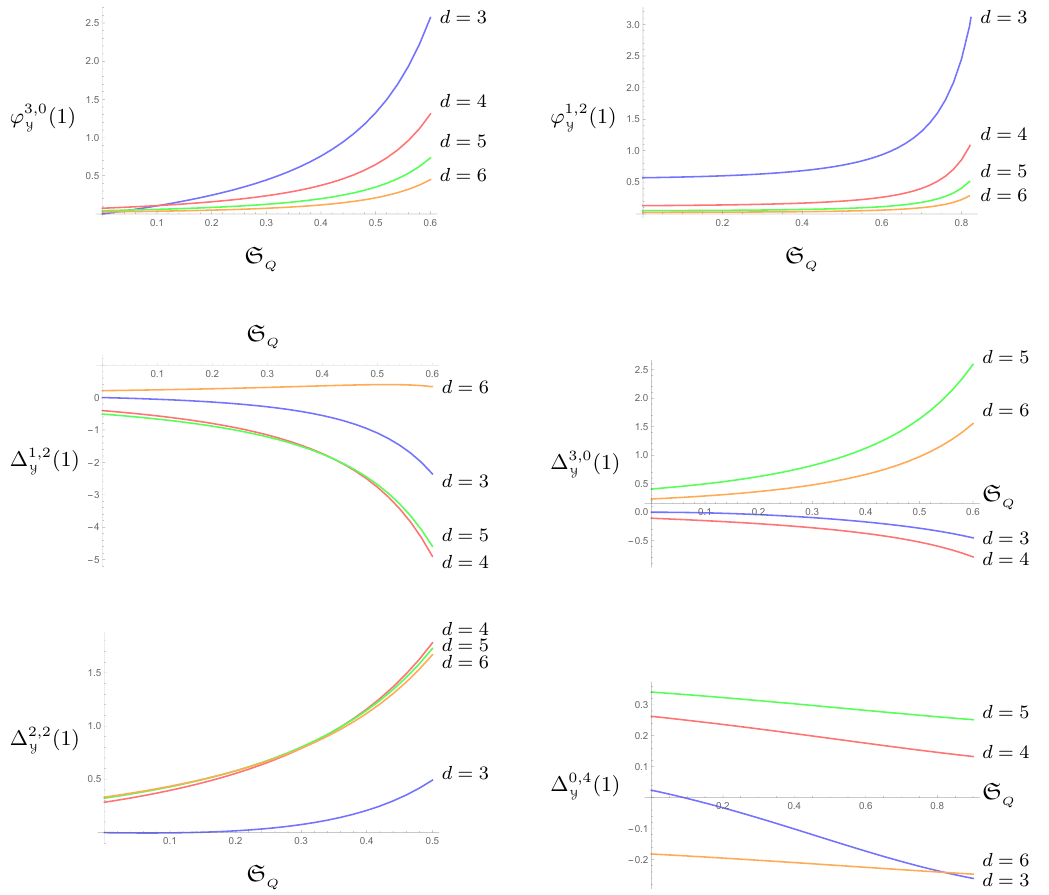
Figure 8 . The charge dependence of parameters determining the coefficients at the quartic order Green’s function of the Markovian vector polarizations encoded in Y plementing the lower order coefficients depicted in figure